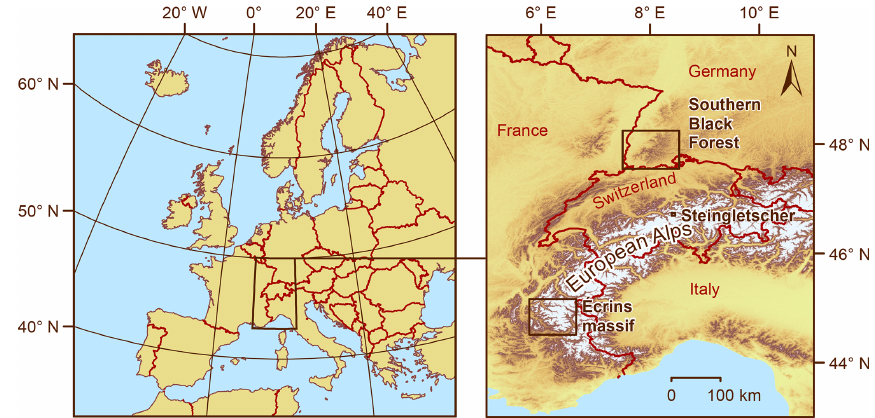
Figure 1. Location of the sites that were chosen for the recalculation of CRE ages. The first site, the Black Forest, lies in the south-western part of Germany close to the border with France and Switzerland. The second site, the Écrins massif, is located in the westernmost European Alps, whereas the third site, the forefield of Steingletscher, is situated in the central Alps further to the north-east. SRTM data (NASA Jet Propulsion Laboratory, 2013) were used to create the map on the right. © EuroGeographics for administrative